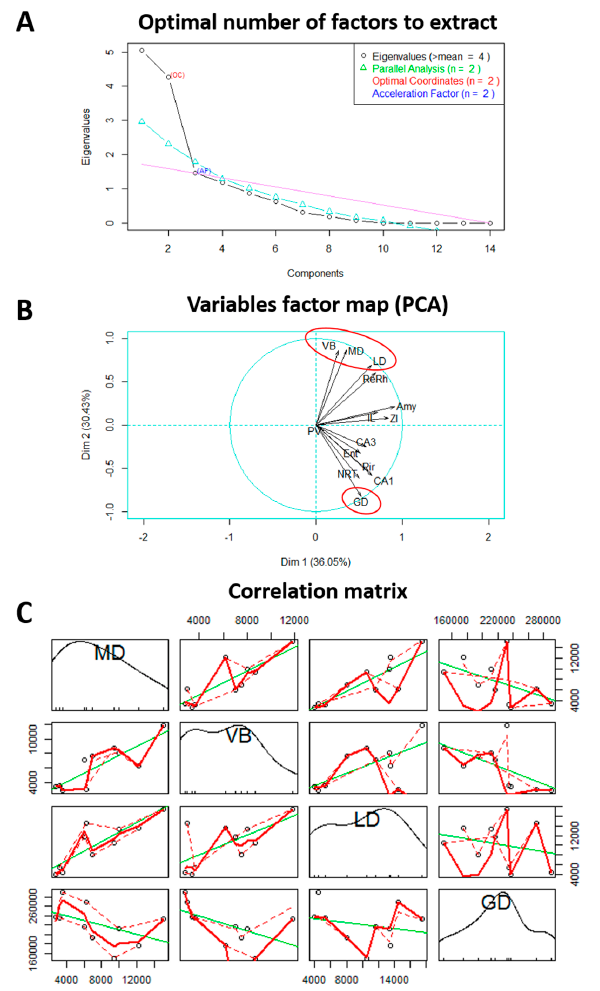
Figure 4. Factorial analysis of brain activity. ( A ) Optimal number of factors to extract; ( B ) Map of the relationship between the different variables mainly showing a positive correlation between ventrobasal (VB), mediodorsal (MD) and laterodorsal (LD) thalamic nuclei, and a negative correlation of these nuclei with dentate gyrus (DG); ( C ) Correlation matrix two-by-two illustrating the correlation between these four structures.